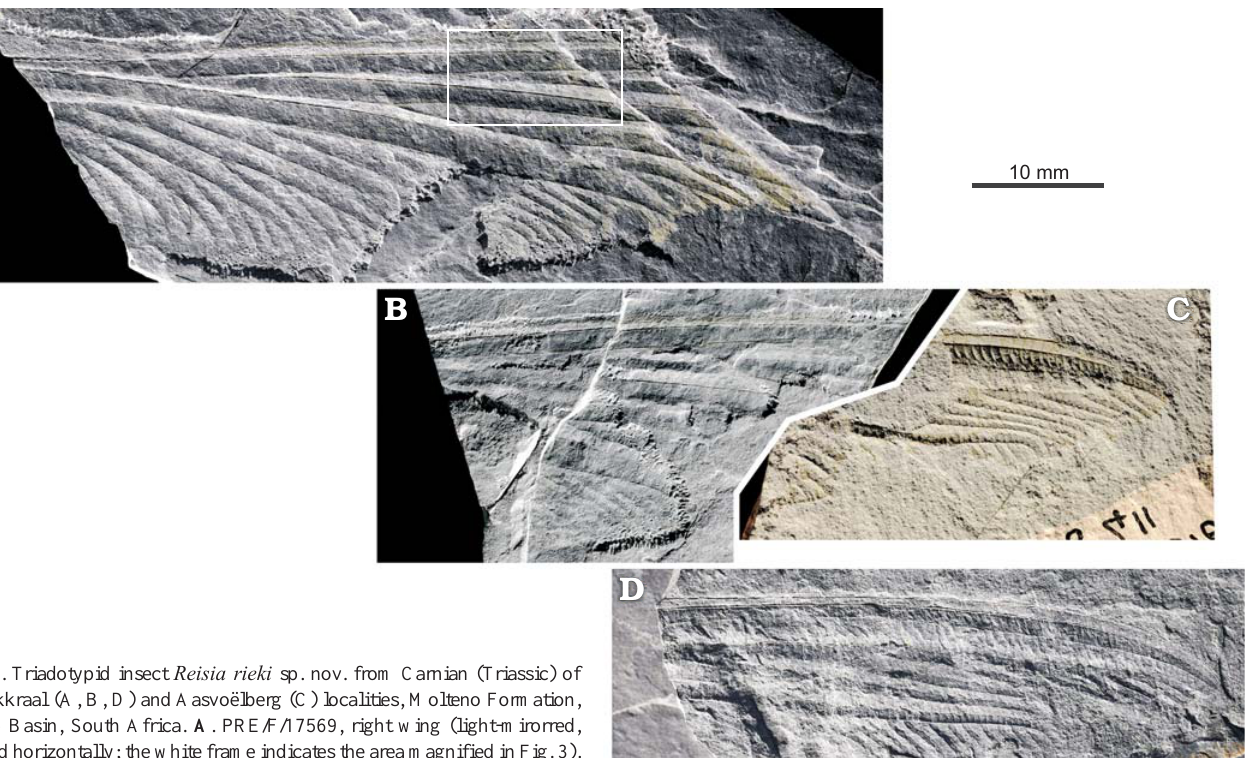
Fig. 2. Triadotypid insect Reisia rieki sp. nov. from Carnian (Triassic) of Kapokkraal (A, B, D) and Aasvoëlberg (C) localities, Molteno Formation, Karoo Basin, South Africa. A . PRE/F/17569, right wing (light-mirorred, flipped horizontally; the white frame indicates the area magnified in Fig. 3). B . PRE/F/16442, left wing (light-mirrored). C . PRE/F/ 10616, right wing (light-mirrored, flipped horizontally). D . PRE/F/17499, right wing (light- mirrored, flipped horizontally).